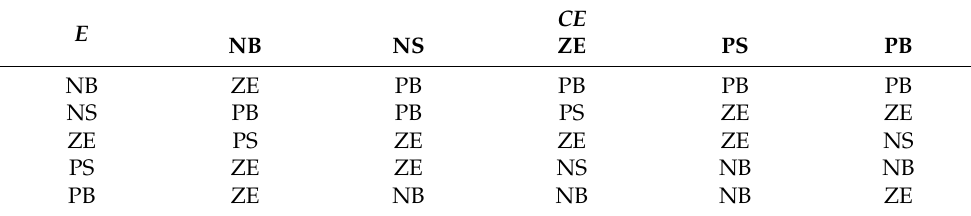
Table 4. Fuzzy rules for the PV